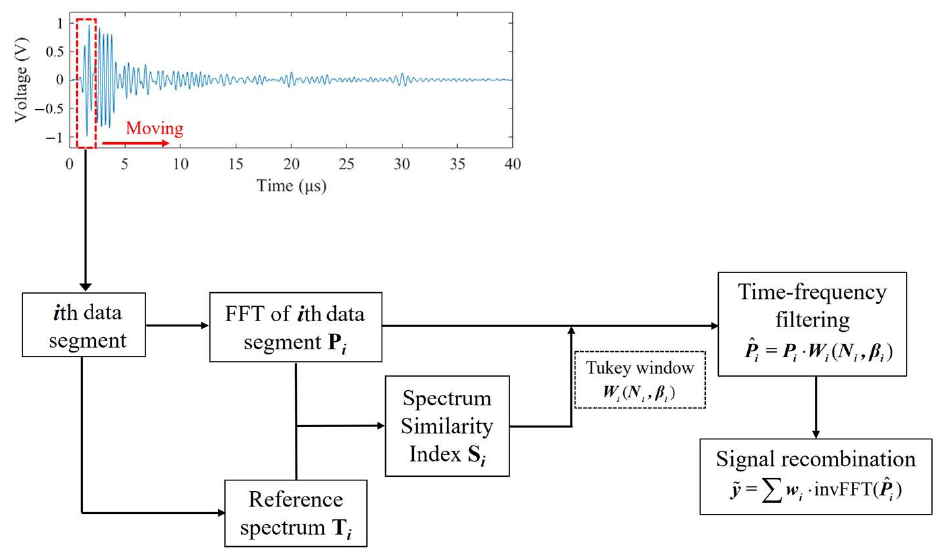
Figure 1. Illustration of the proposed